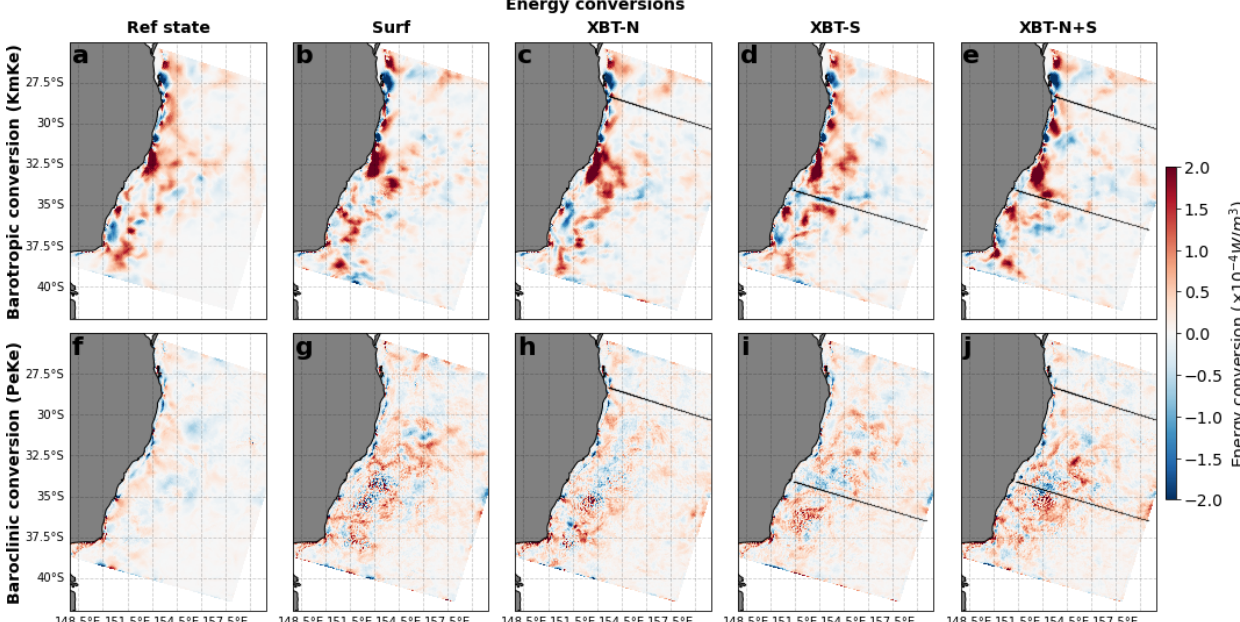
Figure 8. The barotropic conversion rate (KmKe) is shown for the (a) Ref state and (b) Surf, (c) XBT-N, (d) XBT-S, and (e) XBT-N+S OSSEs. The baroclinic conversion rate (PeKe) is shown for the (f) Ref state and (g) Surf, (h) XBT-N, (i) XBT-S, and (j) XBT-N+S OSSEs. In all panels, a positive value indicates conversion from (for panels a – e ) mean kinetic or (for panels f – j ) eddy potential energy into eddy kinetic energy. The XBT-N and XBT-S transect locations are marked in the respective panels. Axes with latitudes are labelled ◦ S, and axes with longitudes are labelled ◦